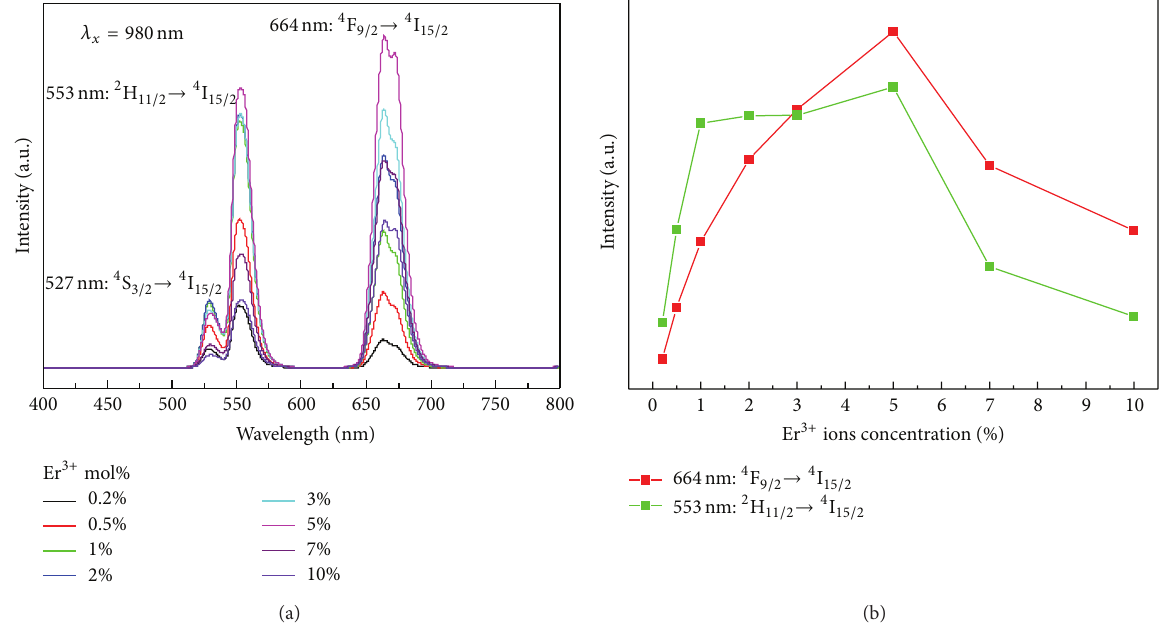
Figure 3: Comparison of UC luminescence spectra of the BaLa 2 ZnO 5 : x Er 3+ /0.10Yb 3+ ( x = 0.2%, 0.5%, 1%, 2%, 3%, 4%, 5%, 7%, and 10%) under 980 nm laser excitation (a), and the variation of green and red emission intensities corresponds to different Er 3+ doping concentration